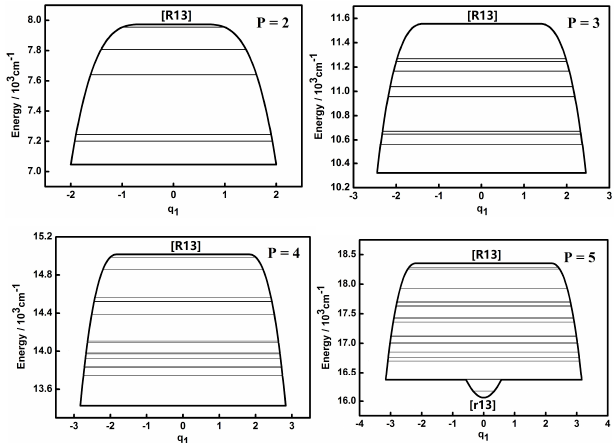
Figure 1. Dynamic potentials of the non-integrable HOCl system (obtained with the H ( q 1 ,p 1 ,q 3 ,p 3 ,P ), q 1 coordinate) with P = 2, 3, 4, 5, and the energy levels included in the dynamic potential are shown by the lines.